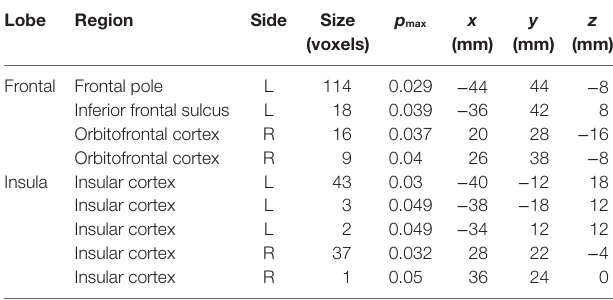
L, left; R, right. The cluster sizes are indicated in voxels in standard space (voxel size: 2 mm 3 isotropic). The maximal p-value is reported in the fifth column. The peak p-value coordinates are reported in the MNI152 standard space. There were two partly separable volumetric clusters detected in the area of the right orbitofrontal cortex, as well as, three left volumetric clusters and two in the right insular cortex.